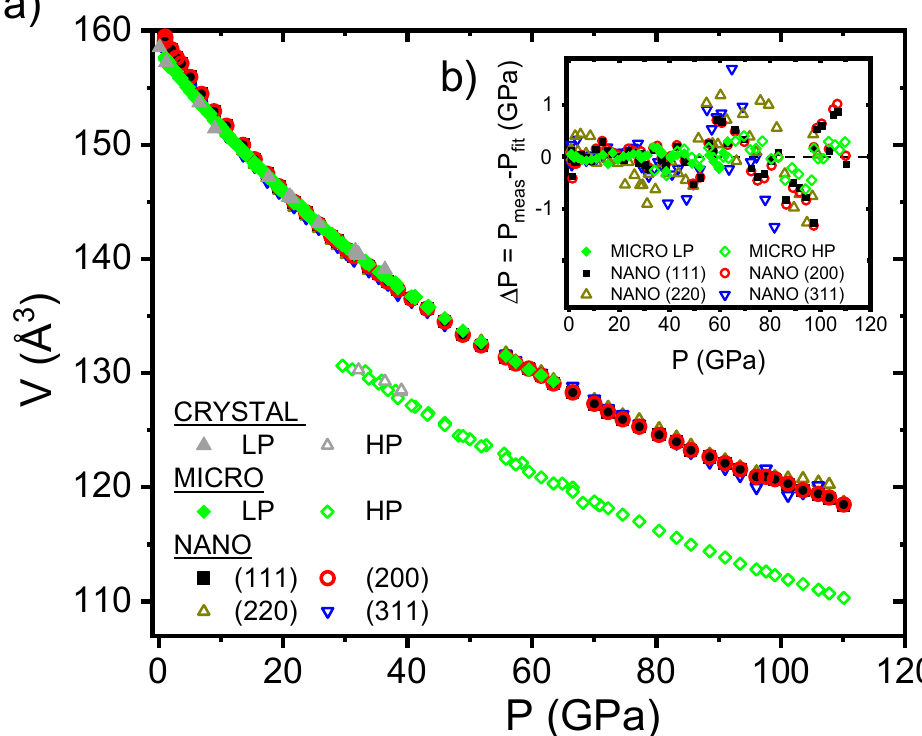
Table 1. The equation of state parameters for the CRYSTAL, MICRO and NANO samples. For the CRYSTAL sample, only the low-pressure phase parameters are presented. For the MICRO sample, the low- and high-pressure parameters are shown.